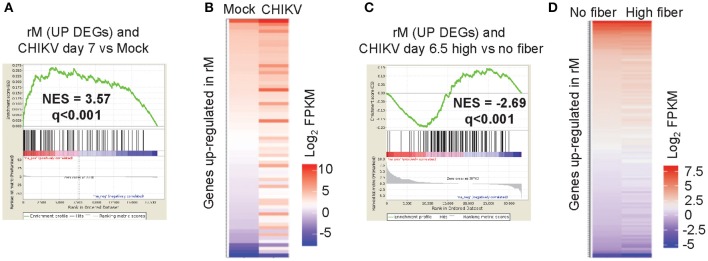
Macrophage resolution phase signature. The gene lists used in this figure are provided in Supplementary Table 1i. (A) A Gene Set Enrichment Analysis (GSEAs) comparing the 146 up-regulated DEGs associated with rM with the expression profile obtained from RNA-Seq analysis of feet day 7 post CHIKV infection vs. mock infected feet (18,517 genes pre-ranked by log2 expression). A normalized enrichment score (NES) and false discovery rate (q) is shown. (B) Heat map illustrating that the 69 core enriched genes identified by the GSEA (out of the 146 genes up-regulated in rM) are generally also up-regulated during peak CHIKV arthritis (day 7 post infection). (C) A GSEA comparing the up-regulated DEGs associated with rM with the expression profile obtained from RNA-Seq analysis of feet of mice fed a high fiber diet vs. feet of mice fed a no fiber diet day 6.5 post CHIKV infection (33,054 genes pre-ranked by log2 expression). (D) Heat map illustrating that the 126 core enriched genes identified by the GSEA (out of the 146 genes up-regulated in rM) are generally down-regulated during peak CHIKV arthritis in mice fed a high fiber diet.